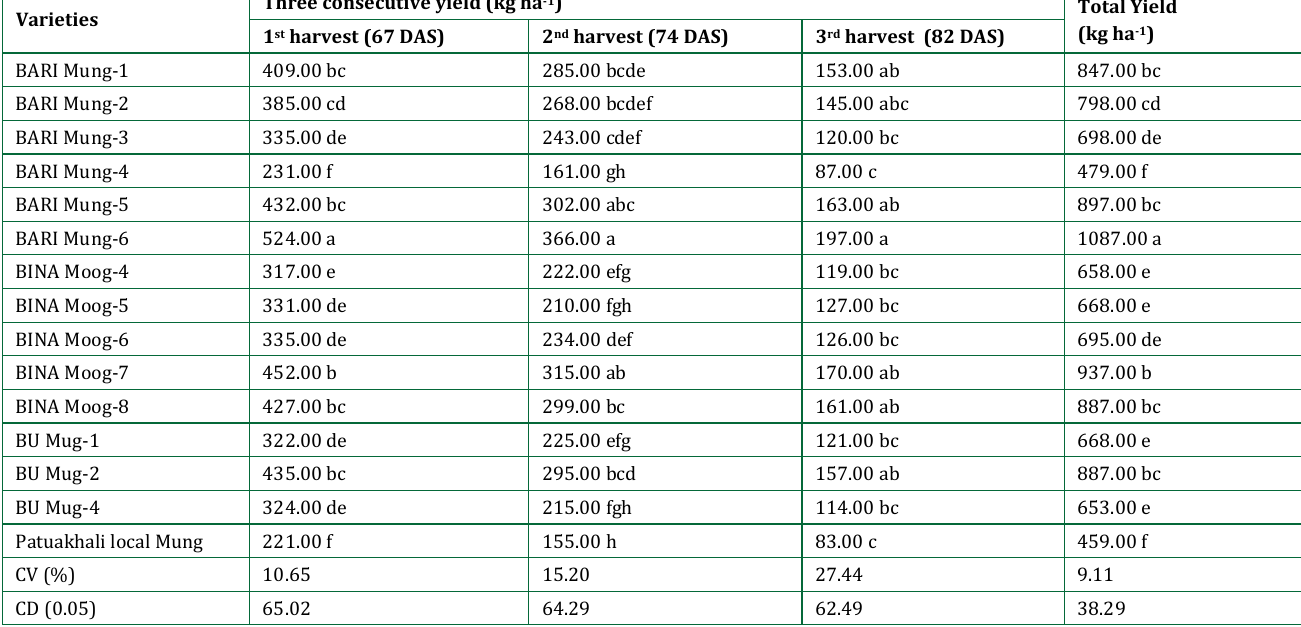
Table 3: Yield of different mungbean varieties obtained from three consecutive harvests